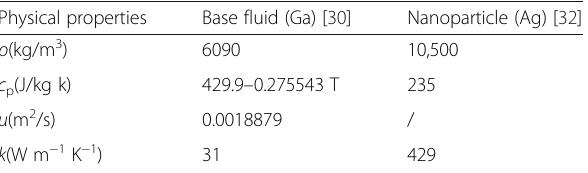
Table 1 Thermo-physical parameters. Thermo-physical parameters of liquid metal gallium and silver nanoparticle Physical properties